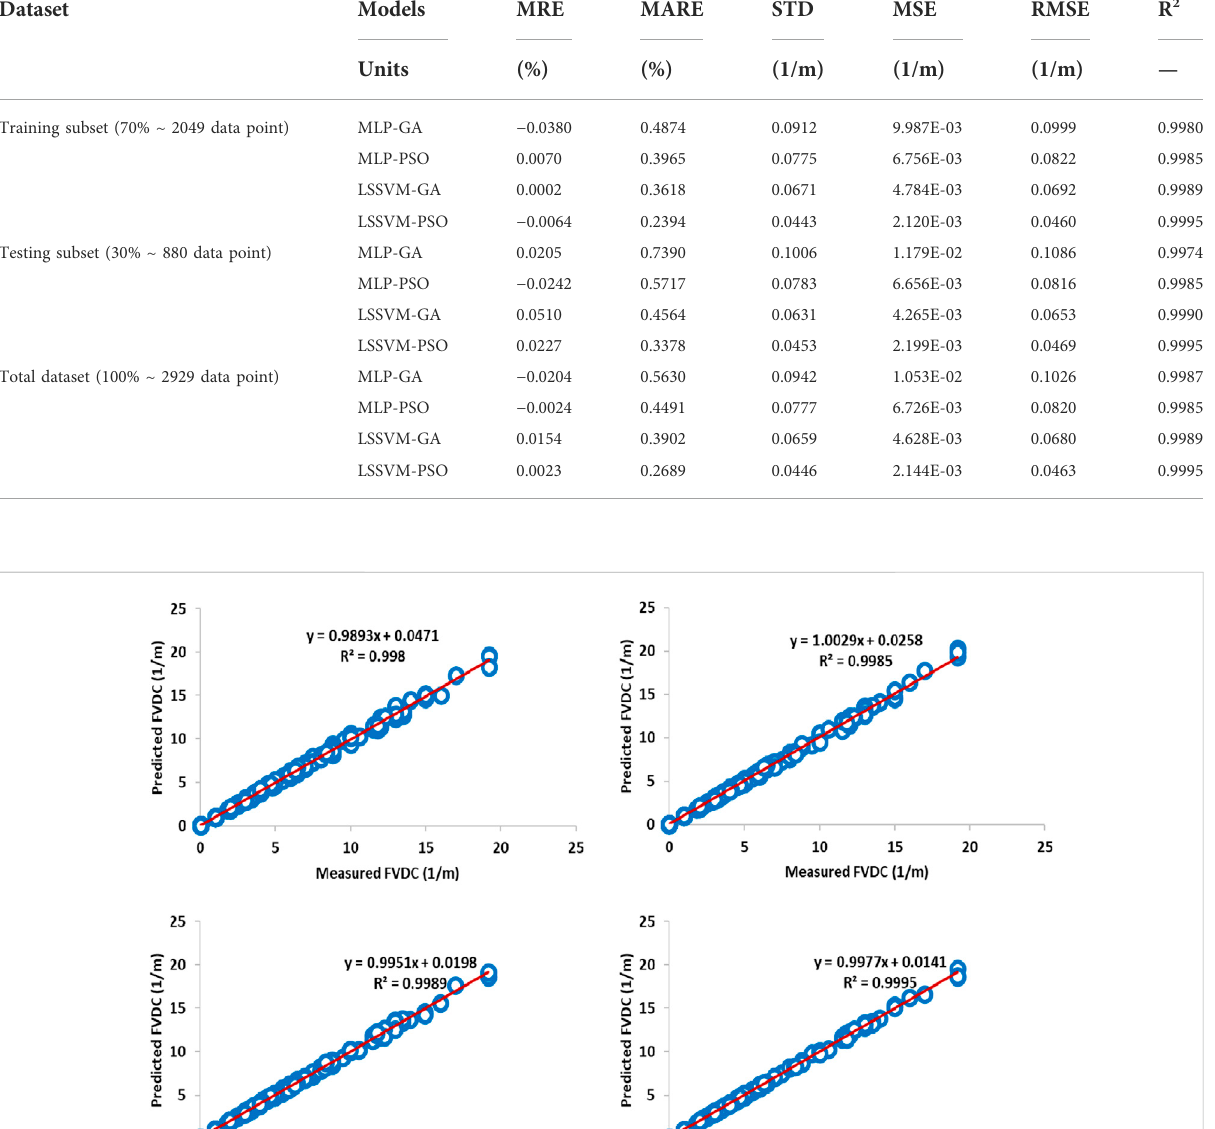
Frontiers in Earth